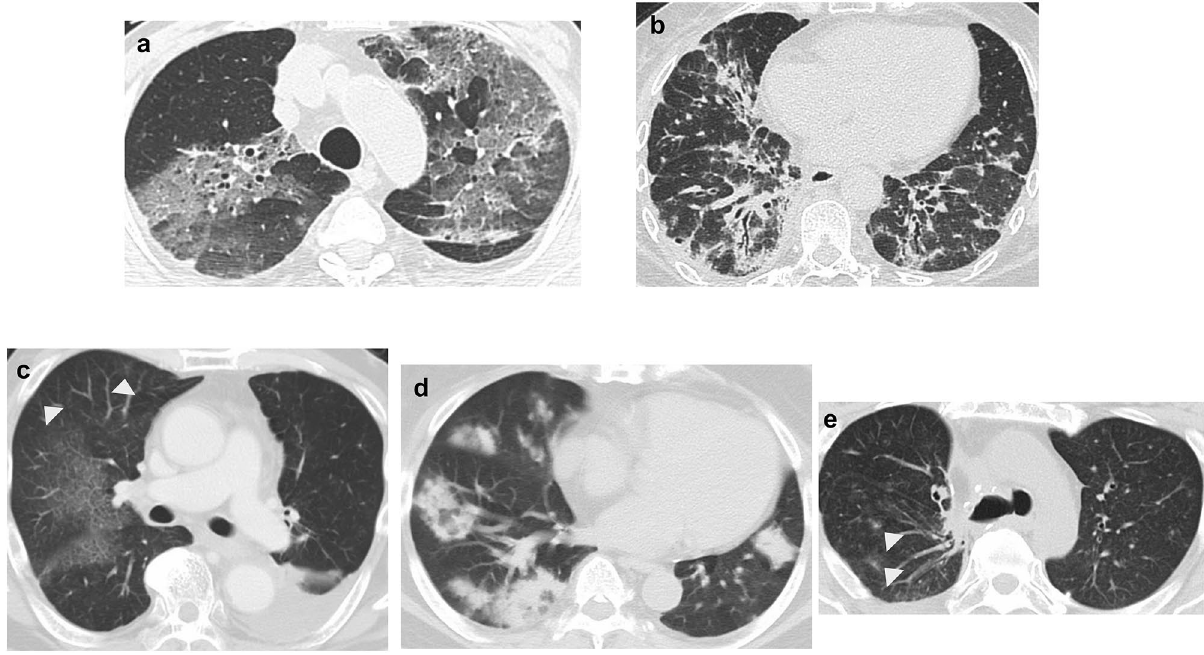
Figure 2. Drug-related pneumonitis showing new diffuse ground-glass opacities, consolidation, and traction bronchiectasis, indicative of a diffuse alveolar damage pattern ( a ). Drug-related pneumonitis showing new ground-glass opacities, irregular reticular opacities, and irregular reticular opacities with predominant lower lung involvement, indicative of the nonspecific interstitial pneumonia pattern ( b ). Drug-related pneumonitis showing new wide areas of faint ground-glass opacities with some patchy nodular lesions (arrowheads), indicative of the hypersensitivity pneumonitis pattern ( c ). Drug-related pneumonitis showing new ground- glass opacities and consolidations with multifocal distribution, indicative of the organizing pneumonia pattern ( d ). Drug-related pneumonitis showing new focal opacity areas (arrowheads). Lesions disappear only with withdrawal of drug therapy (not shown here), with features compatible with the simple pulmonary eosinophilia pattern ( e